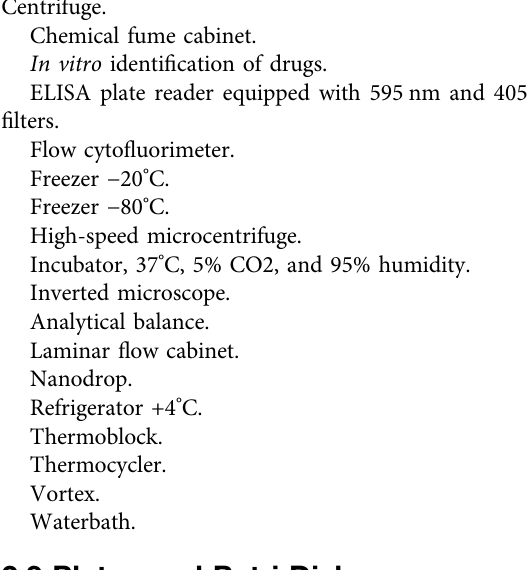
Frontiers in Toxicology |